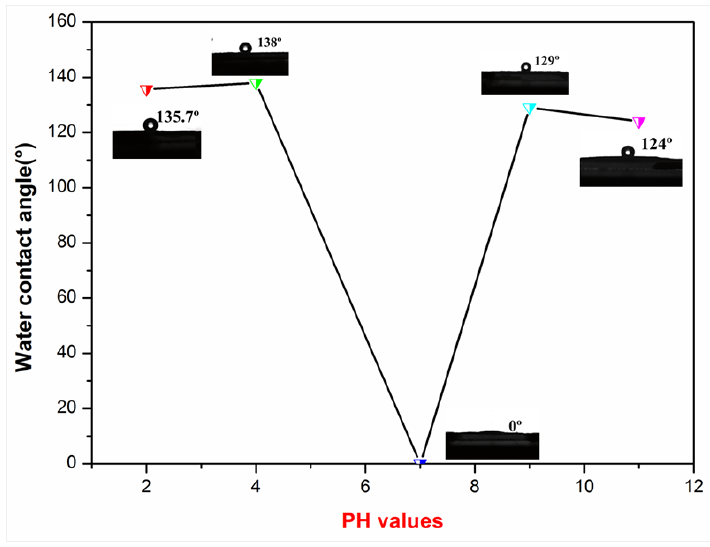
Figure 6. Effect of pH on the WCA of C12-KH560-NCC powders.